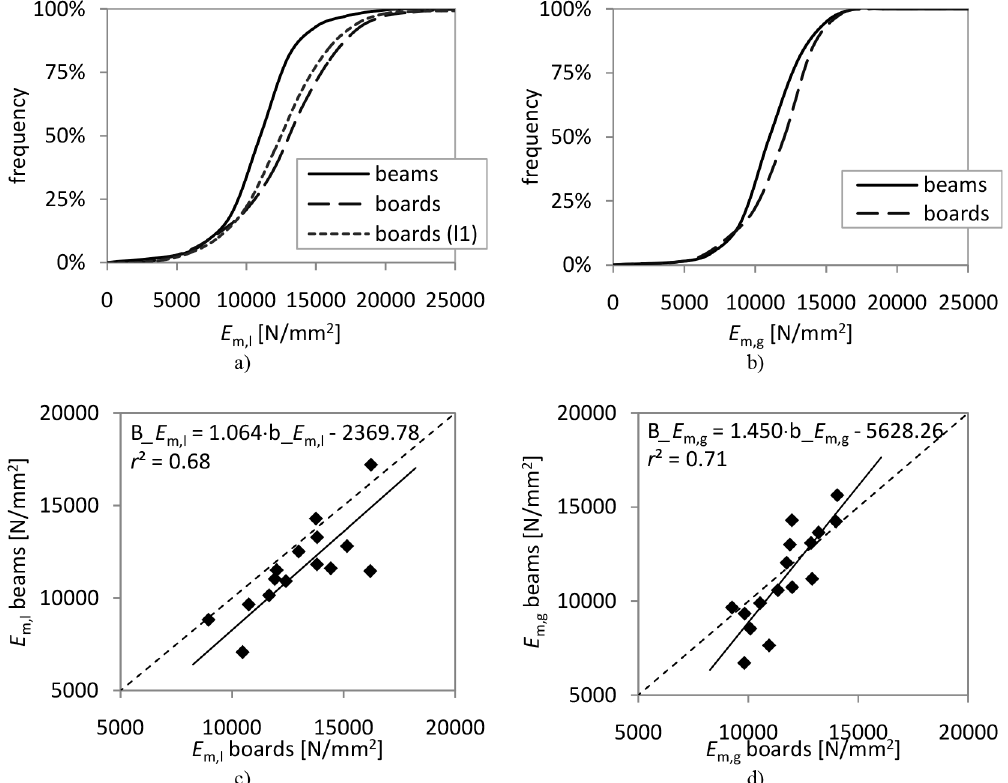
Fig. 10. Correlation between bending tests in phase 2 and 3: a) cumulative distribution functions for E m,l (boards l 1 = segments of sawn boards in the l 1 length of the beams according to EN 408:2003); b) cumulative distribution functions for E m,g ; c) correlation between E m,l ; d) correlation between E